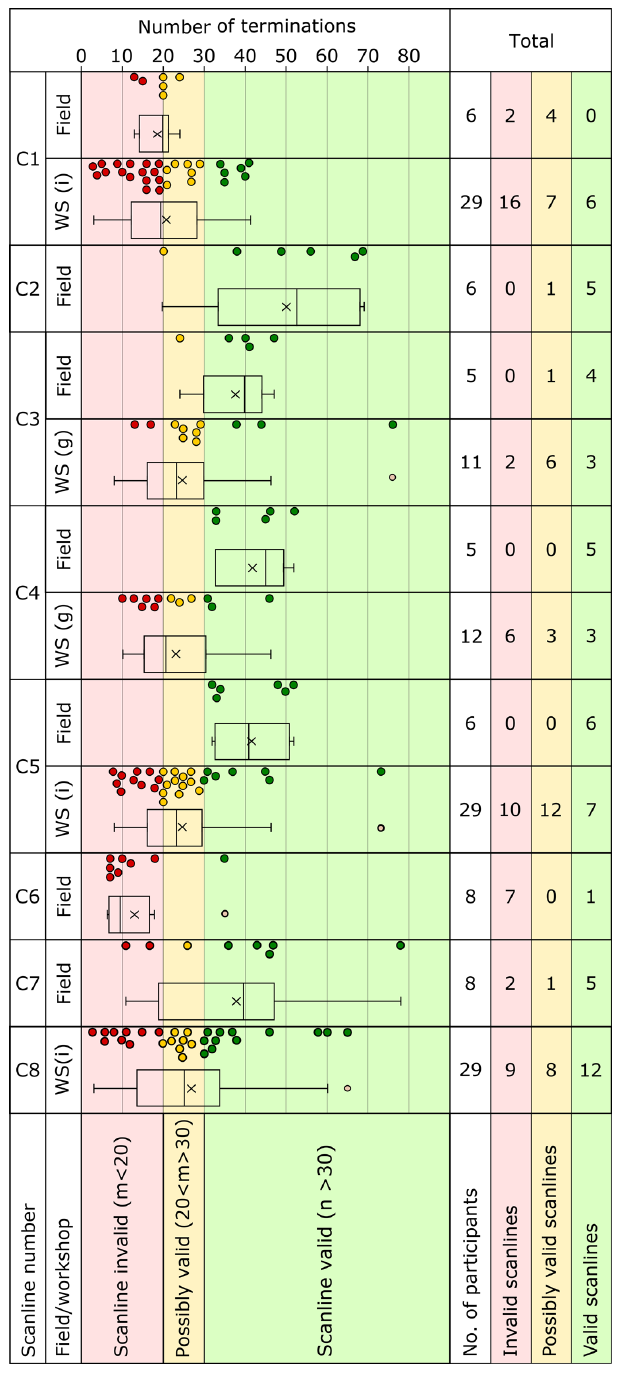
Figure 10. The effect of subject bias on the validity of circular scan- lines. The number of terminations recorded by individuals or groups is displayed for each circle and colour-coded depending on where a valid (>30, green), possibly valid (20–30, yellow), or invalid (<20, red) number of terminations was